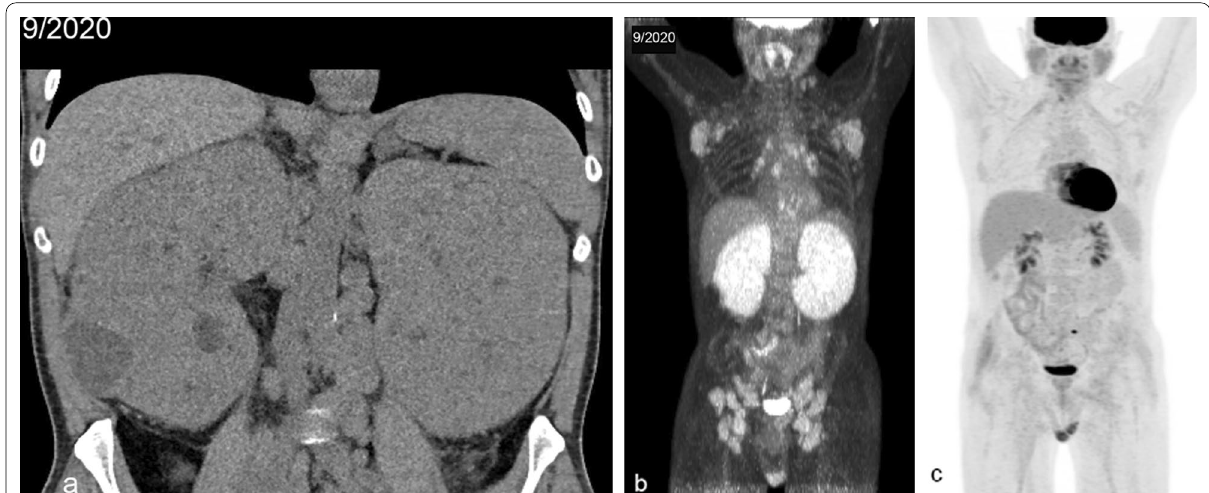
Fig. 7 Nephromegaly of renal lymphoma . Coronal noncontrast CT ( a ) demonstrates symmetric marked enlargement of the bilateral kidneys from lymphomatous infiltration in this patient with mantle cell lymphoma. Concurrent PET/CT in 9/2020 ( b ) demonstrates marked F18-FDG avid bilaterally enlarged kidneys as well as extensive supradiaphragmatic and infradiaphragmatic lymphadenopathy. Follow-up F18-FDG PET/CT in 11/2020 ( c ) following chemotherapy shows complete metabolic and radiologic response with normalized renal size and